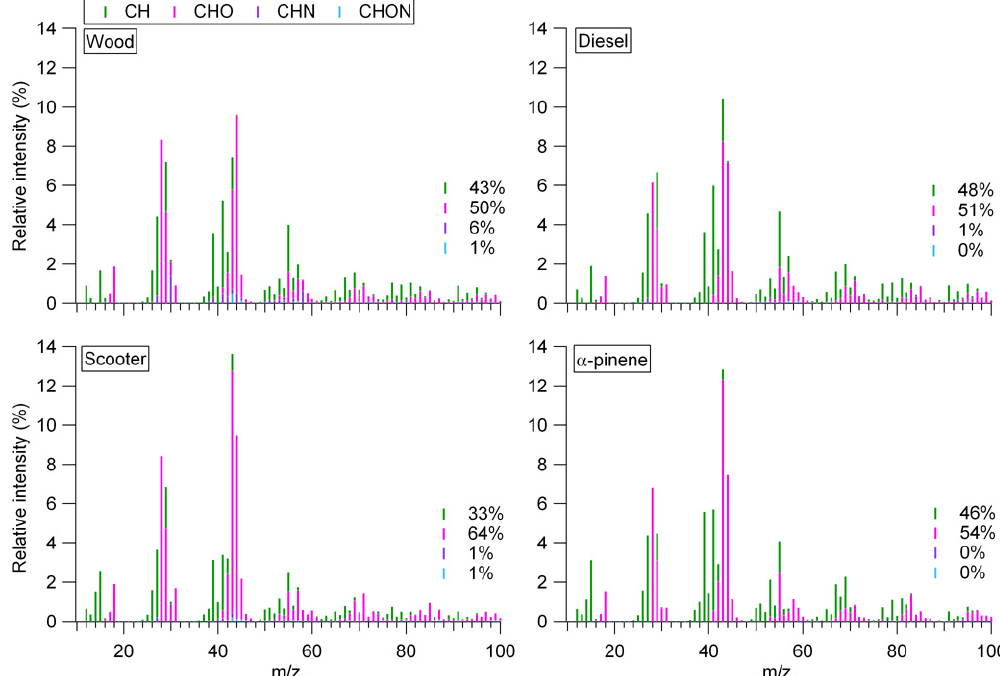
Fig. 3. Comparison of the normalized high-resolution family mass spectra after five hours of aging. Ions are grouped into the families CH, CHO, CHN and CHON based on their elemental composition. The spectra shown for wood, diesel and scooter are averages of the two experiments. The α -pinene spectrum is from the ozonolysis experiment.